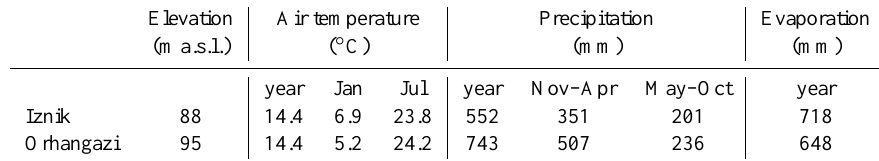
Table 1. Average climate data and elevation of Iznik and Orhangazi (Wester, 1989; see Fig. 2 for the locations).